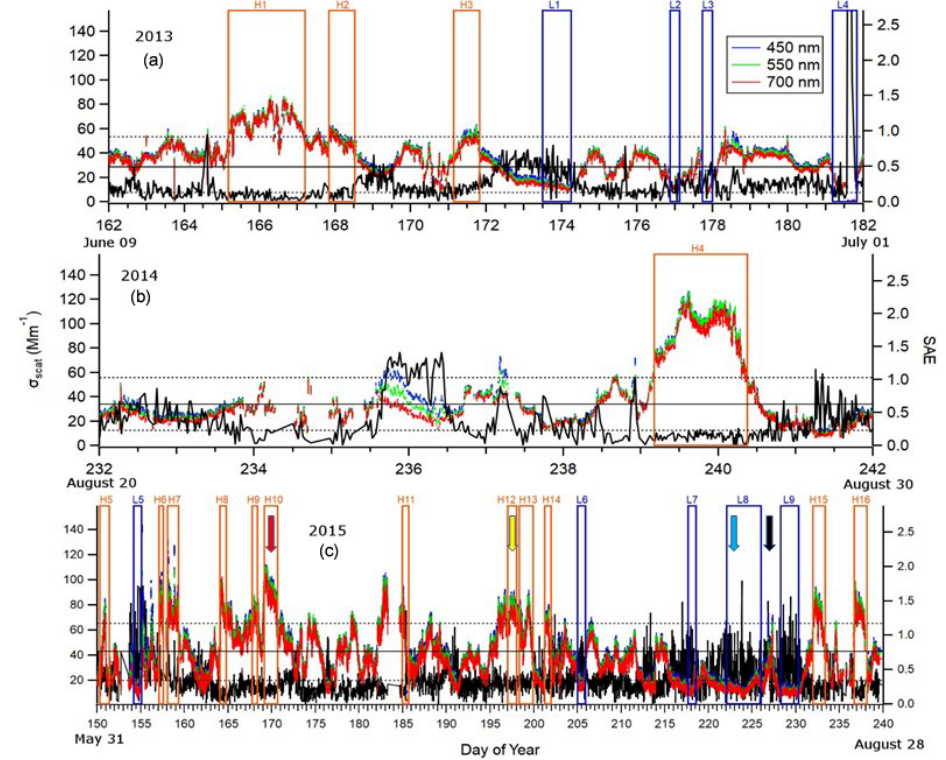
Figure 2. Aerosol scattering coefficients and SAE measured at CSJ during the summers of (a) 2013, (b) 2014, and (c) 2015. The orange and blue squares identify the periods of high and low dust, respectively. The arrows in the 2015 time series identify the periods whose cloud properties were analyzed in detail when the air origins were from the African Sahel (red), Saharan desert (orange), Atlantic Ocean (blue), and southeast of Puerto Rico (black). These periods correspond to those evaluated in the back-trajectory analysis. The horizontal solid and dashed lines are the average and standard deviation values of the scattering coefficient at